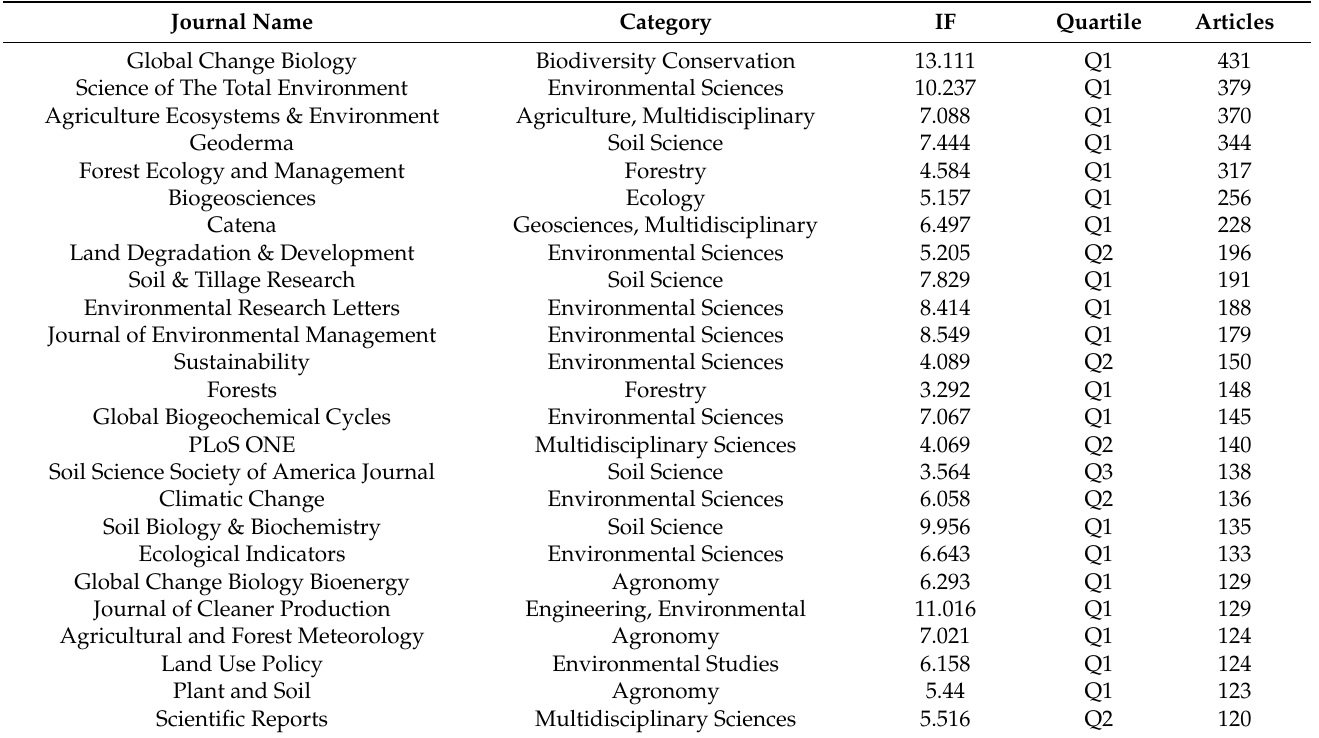
Table 1. Top 25 Journals in Terms of the Impact of Land Use Change on Soil Carbon Sequestration from 1985 to